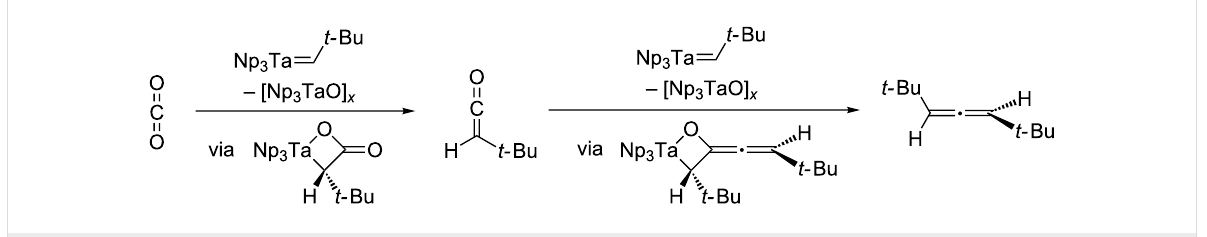
Figure 2: Quenching of M ═ E FLPs by dimerization: (a) generic M δ + ═ E δ− case, and (b) Bergman's arylimido zirconium(IV) [25].